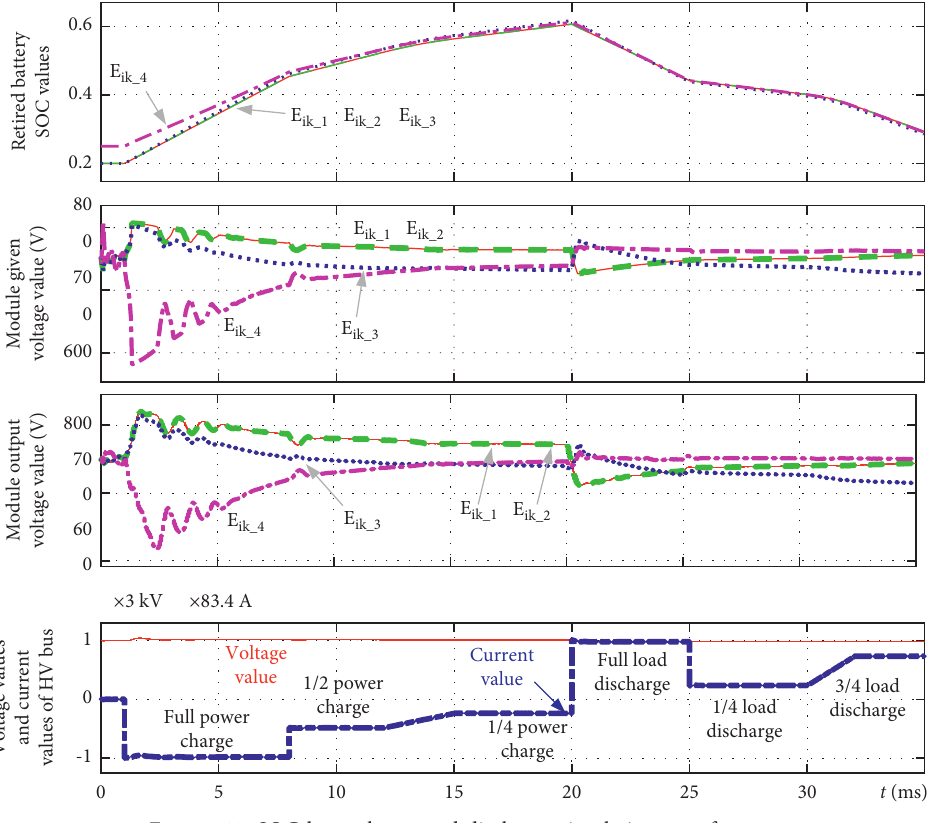
Figure 11: SOC layer charge and discharge simulation